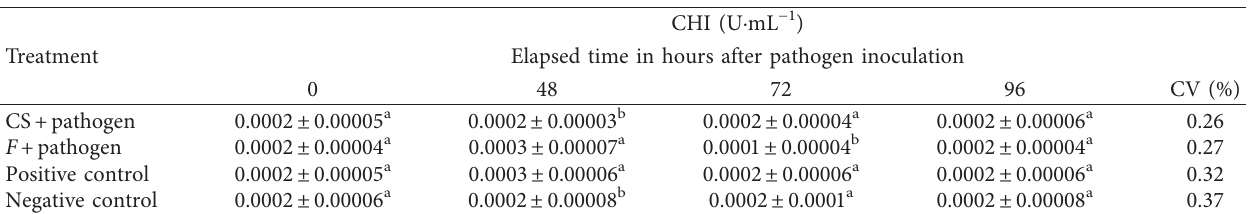
Table 5: Average chitinase (CHI) activity in guarana